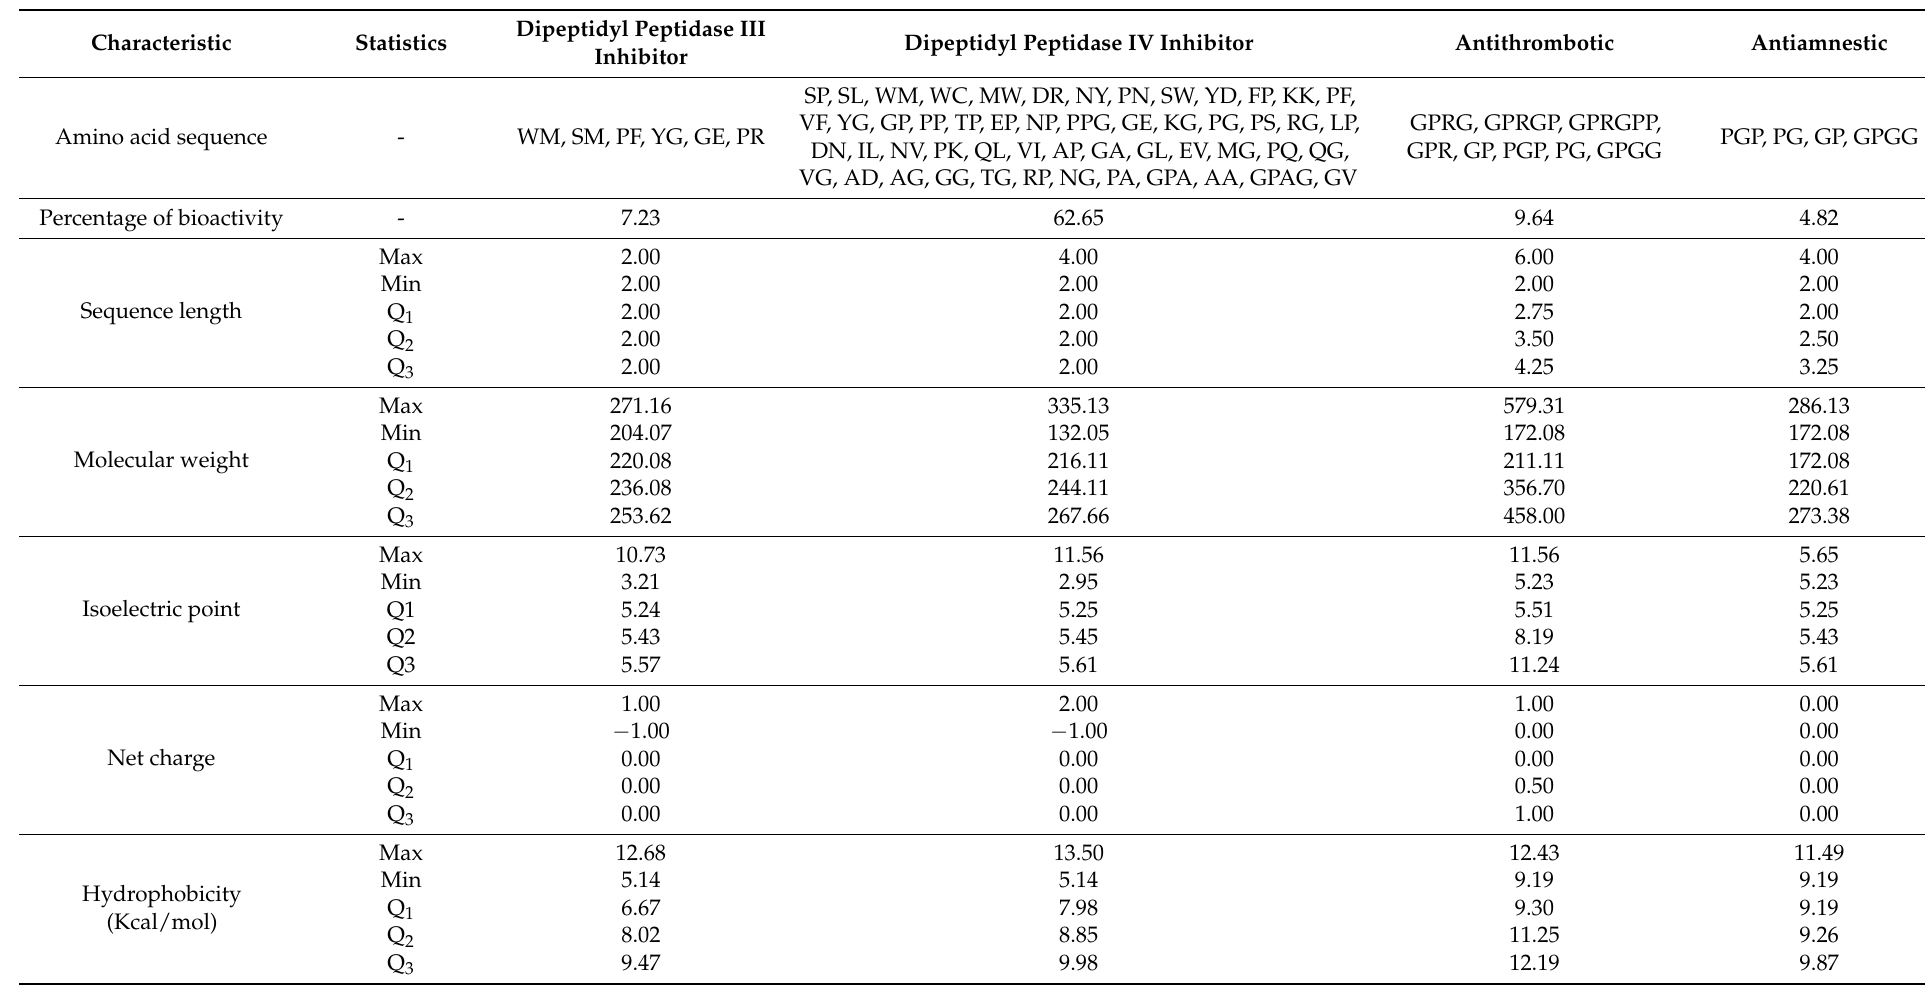
Table 6. The characteristics of the bioactive peptides in the PPS fraction of <3